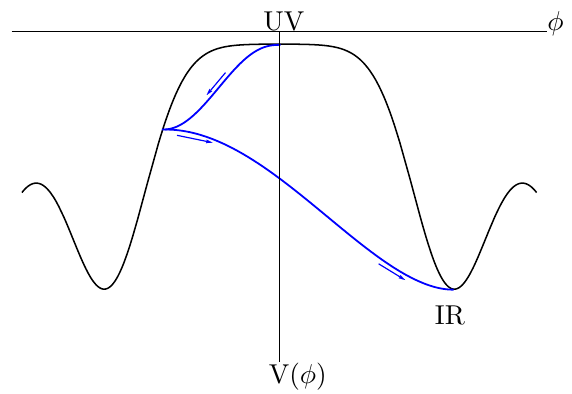
Figure 2 . Sketch of a bouncing RG-(cid:13)ow at T = 0, with j < 0.